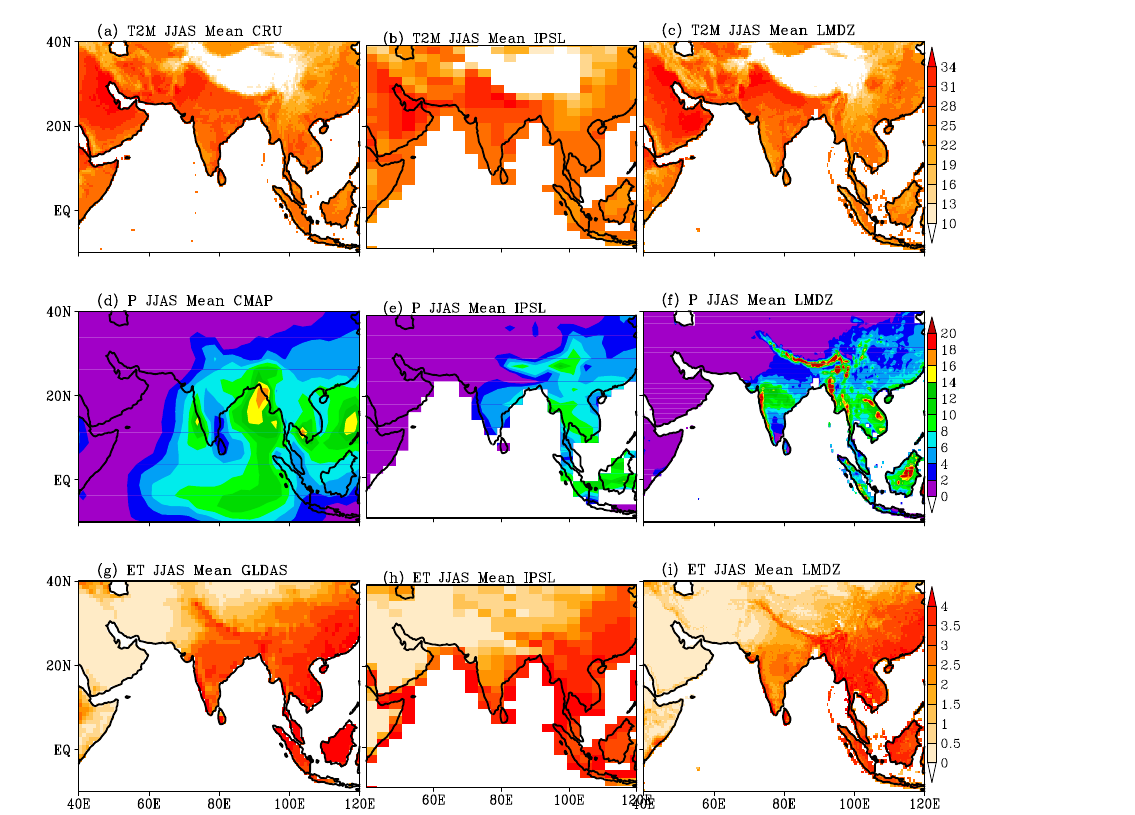
Figure 2. Spatial distributions of JJAS mean (top) 2m air temperature (T2M; ◦ C), (middle) precipitation (P; mmd − 1 ) and (bottom) evap- otranspiration (ET; mmd − 1 ) from (a, d, g) observations or multi-model data, from HIST simulations of (b, e, h) IPSL and (c, f, i) LMDZ models. The period of analysis for CMAP and GLDAS is 1979–2005 and for CRU, model simulations the time period is